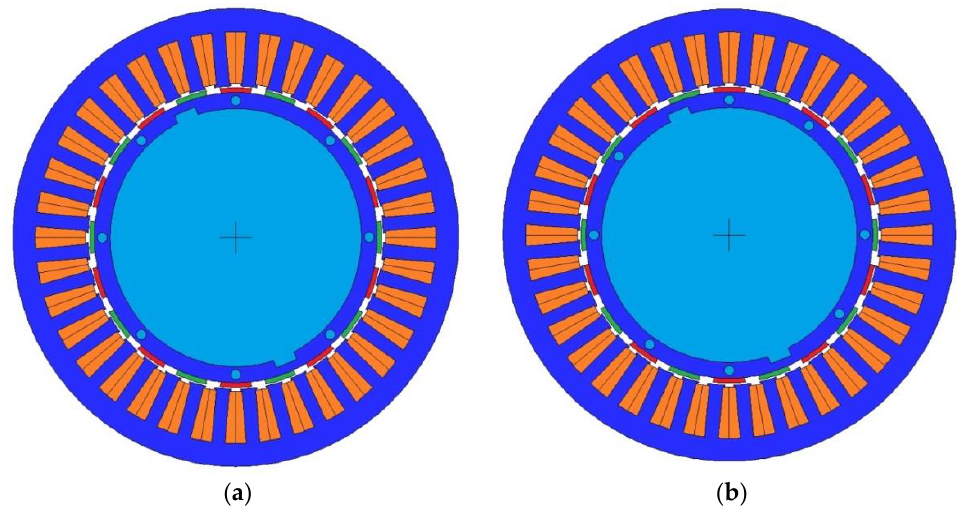
Figure 1. Cross section area of the permanent magnet synchronous generator (PMSG): ( a ) Original model; ( b ) Model with centered holes.